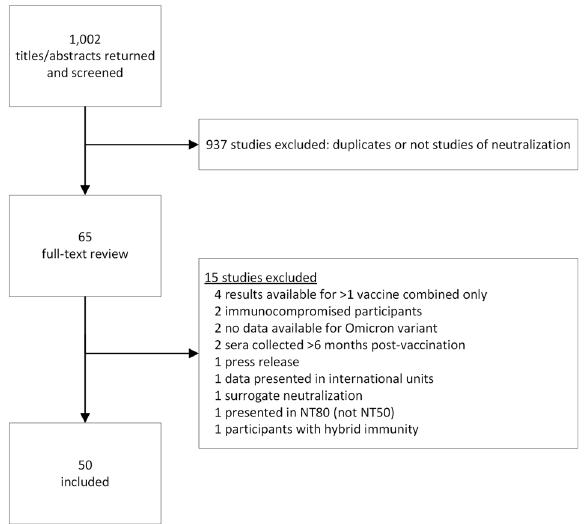
Fig. 2 PRISMA fl ow diagram. Overview of the systematic literature search and study selection